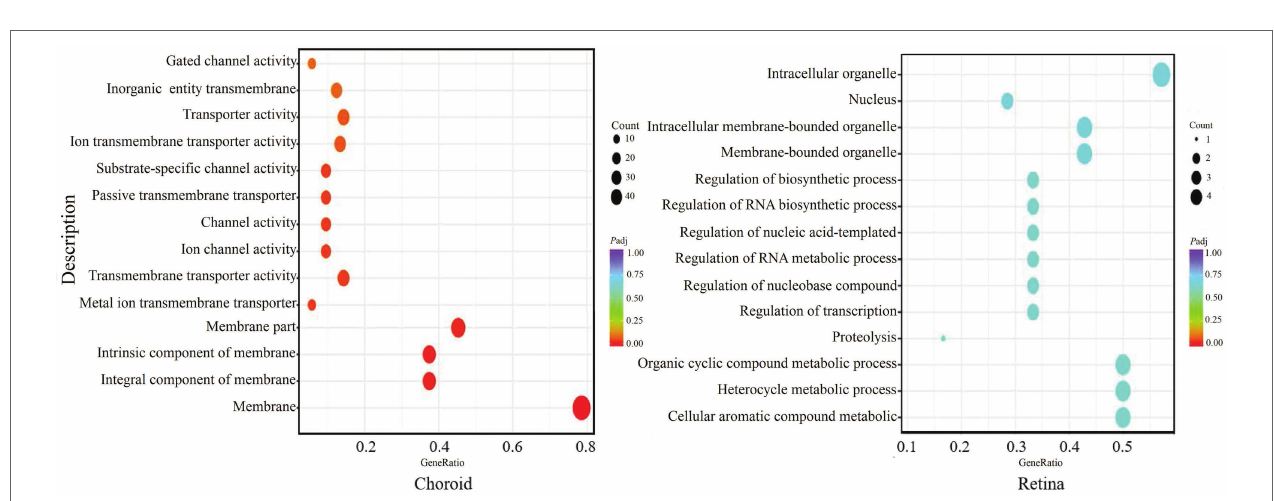
FIGURE 9 | GO enrichment of the significant differentially expressed genes (DEGs) in the choroid and retina. The abscissa shows the rich factors and the ordinate represents the pathways. Size of each point indicates the number of candidate target genes in the GO term, and the color of each point corresponds to the value of p after correction.